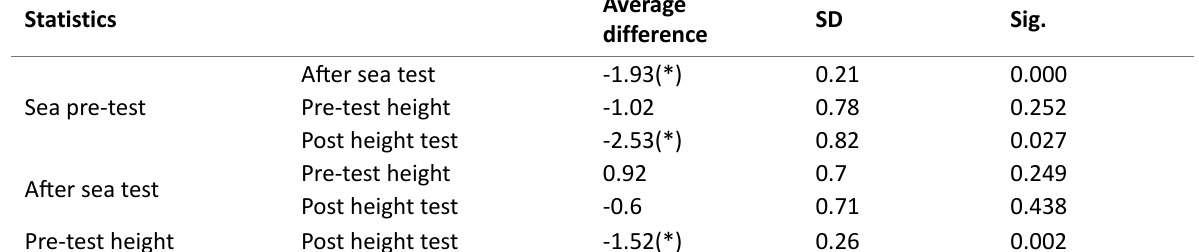
Table 4. Test of repeated measurements of experimental neutrophils in different stages Statistics